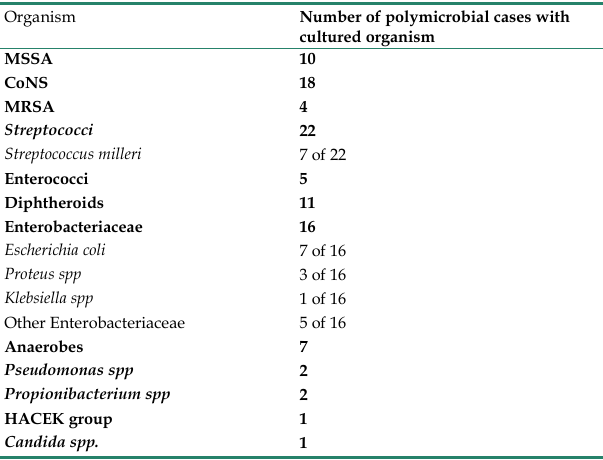
Table 4. Breakdown of the organisms cultured in the 32 cases with polymicrobial